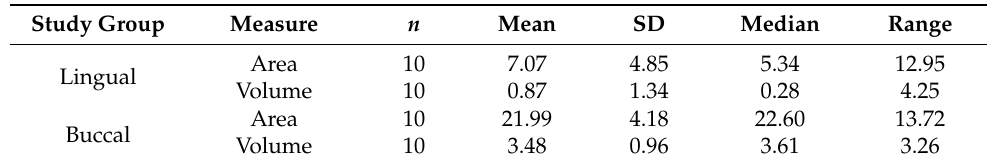
Table 1. Descriptive statistics of the area (mm 2 ) and volume (mm 3 ) of remaining cement after buccal and lingual multibracket appliance debonding.